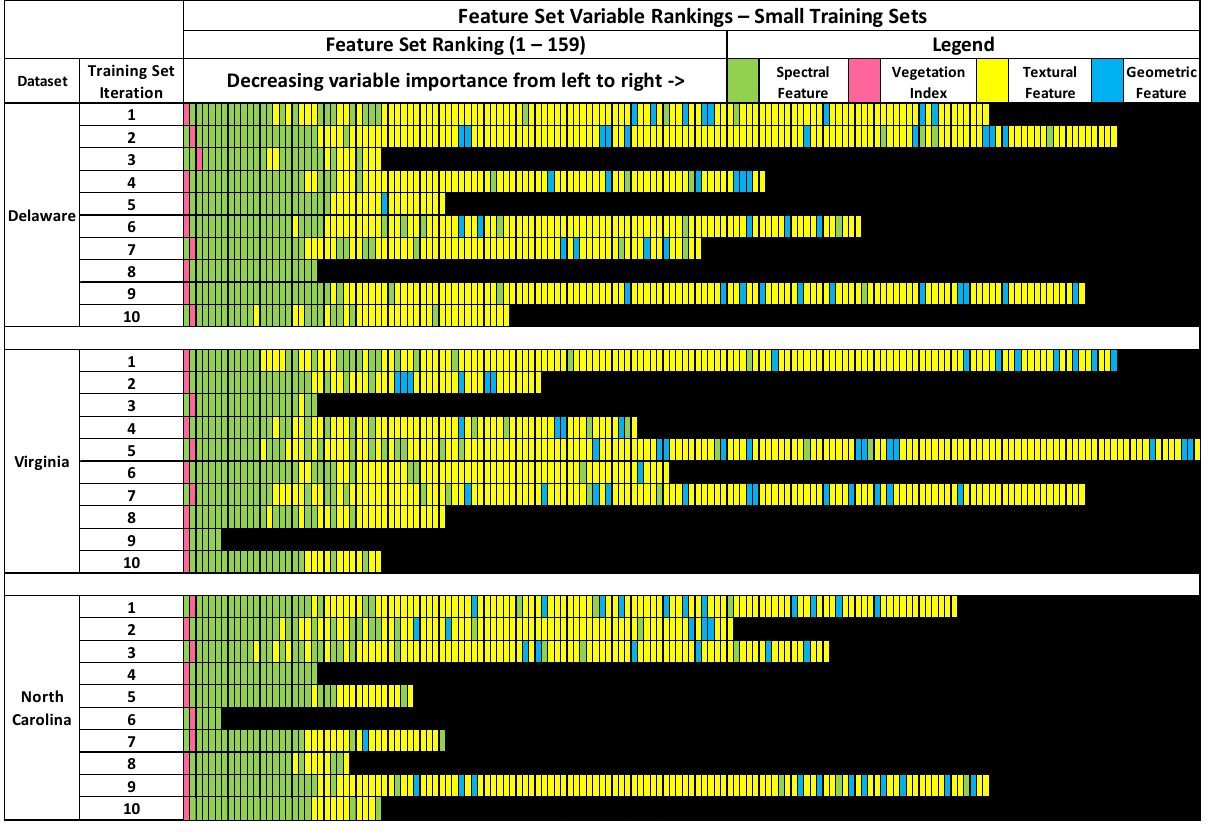
Figure 4. RFE-derived feature set rankings for small Delaware, Virginia, and North Carolina training sets. Each row indicates the features that were found to be optimal for the training set by the RFE process. Each cell indicates the type of feature that was included in the RFE-derived feature set, ranked in decreasing importance to the accuracy of the classification from left to